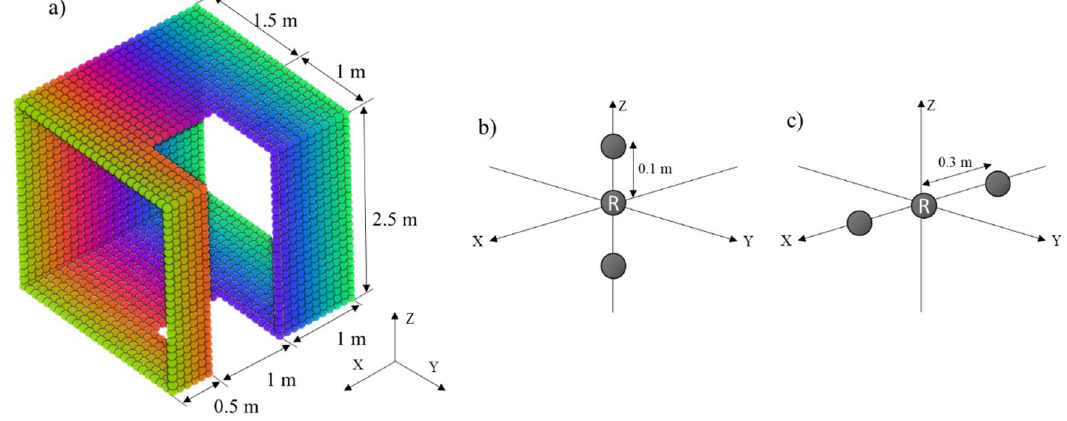
Figure 3 . Point cloud of an open synthetic cube with dimensions and structuring elements for testing.